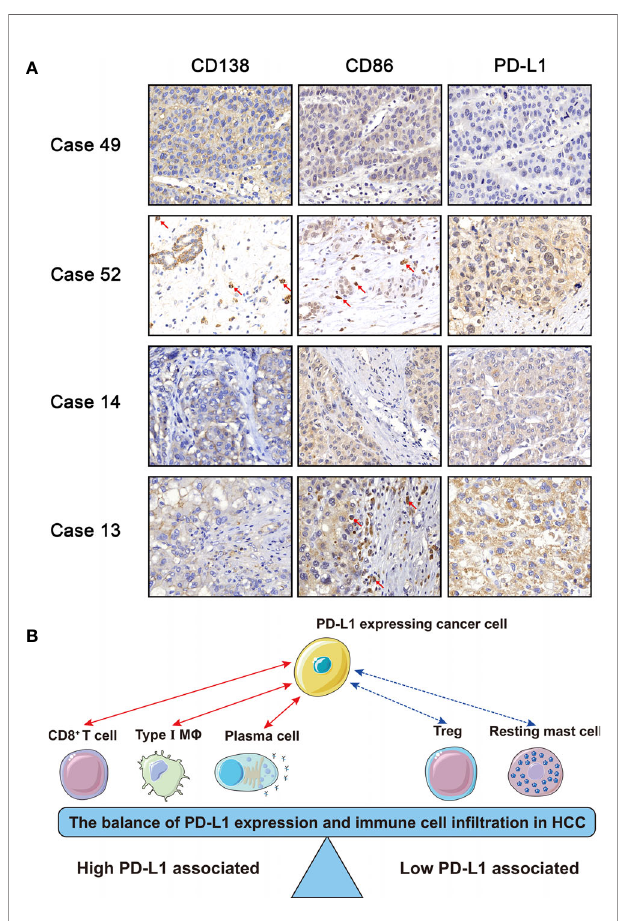
FIGURE 6 | (A) Immunohistochemistry of CD138, CD86, and PD-L1. Case 49: − (CD138), − (CD86), and 0 (PD-L1); Case 52: + (CD138), + (CD86), and 2 (PD-L1); Case 14: − (CD138), − (CD86), and 1 (PD-L1); Case 13: − (CD138), + (CD86), and 2 (PD-L1). (B) Schematic diagram of the balance of immune cells and PD-L1. The red solid line represented that the PD-L1 expression was positively correlated with M1 macrophages, plasma cells, and CD8 + T cells, while the blue dotted line represented that the PD-L1 expression was negatively correlated with resting mast cells and regulatory T cells.